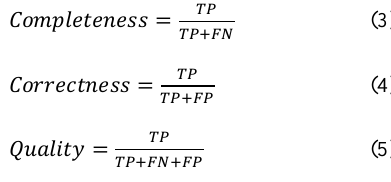
Table 1. The features of the Sentinel input data for Chrisoupoli